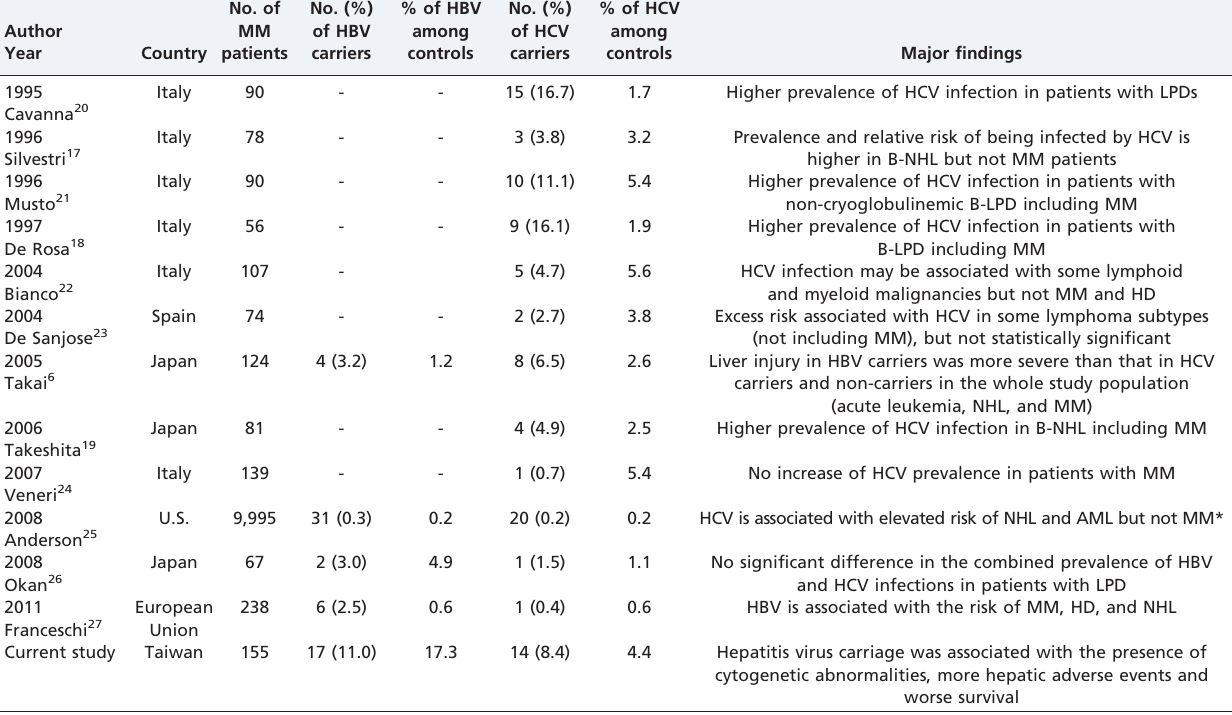
Table 5 - Summary of studies (with $ 50 enrolled patients) exploring the prevalence of chronic hepatitis virus infection in multiple myeloma